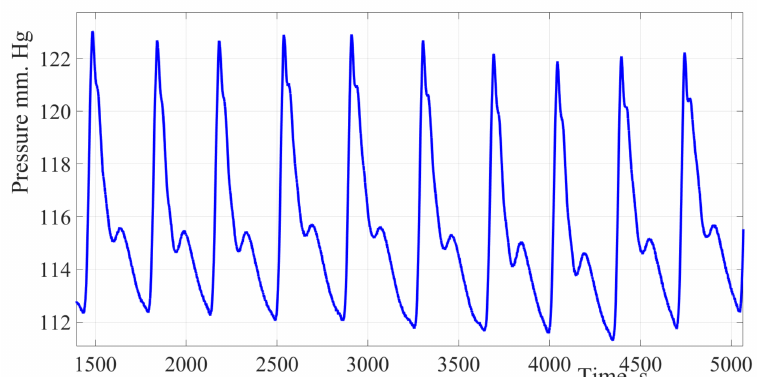
Figure 1. Pulse wave signal recorded using hydrocuff technology. The presented fragment shows the presence of a respiratory component, which leads to a change in the oscillation’s amplitude. When finding an oscillation with the maximum amplitude, it is necessary to take into account the influence of the respiratory component.